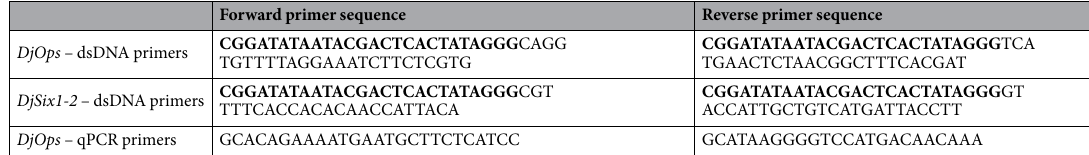
Table 2. Primers used for RNAi (dsDNA primers) and RT-qPCR (qPCR primers) experiments. Primer sequences are reported 5 ′ to 3 ′ . T7 promoter adaptor sequence is highlighted in